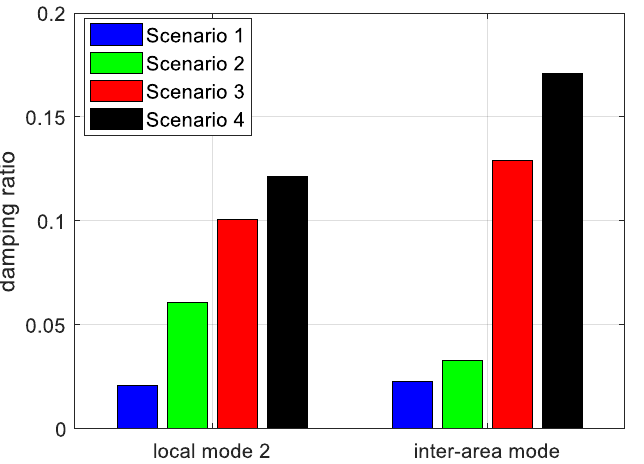
Figure 12. Damping of different scenarios (Scenario 1: System without BESS; Scenario 2: System with BESS; Scenario 3: System with VISMA-FFO; Scenario 4: System with VISMA-proposed).